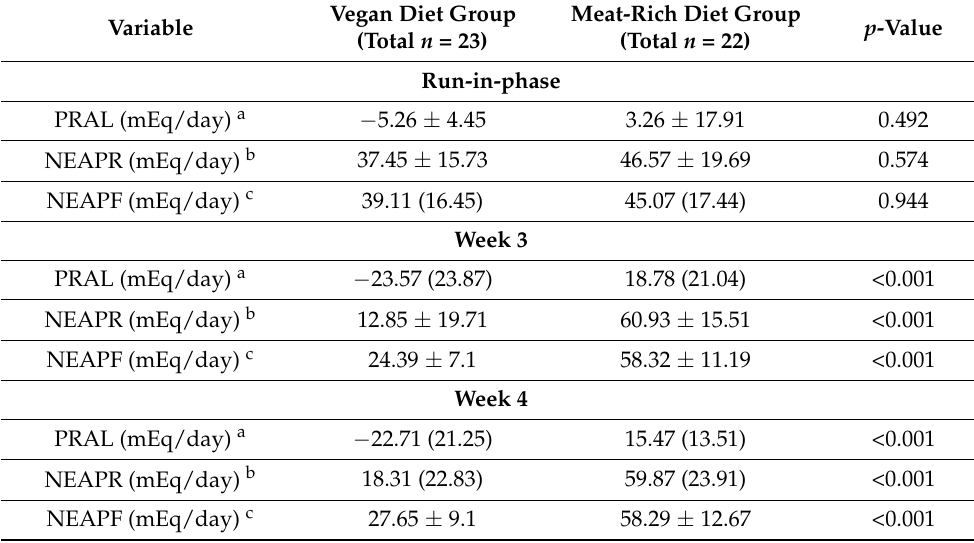
Table 3. DAL scores during the run-in-phase and at week 3 and 4 week across the vegan diet and the meat-rich diet group: A comparison. Normally distributed data are shown as mean ± standard deviation; not normally distributed data are shown as medians (interquartile range). p -values from post hoc tests for which Group × Time interactions were significant. Number of participants used for statistical analysis after outlier removal: (a) vegan diet group, n = 23, meat-rich diet group, n = 21; (b) vegan diet group, n = 23, meat-rich diet group, n = 22; (c) vegan diet group, n = 23, meat-rich diet group, n =